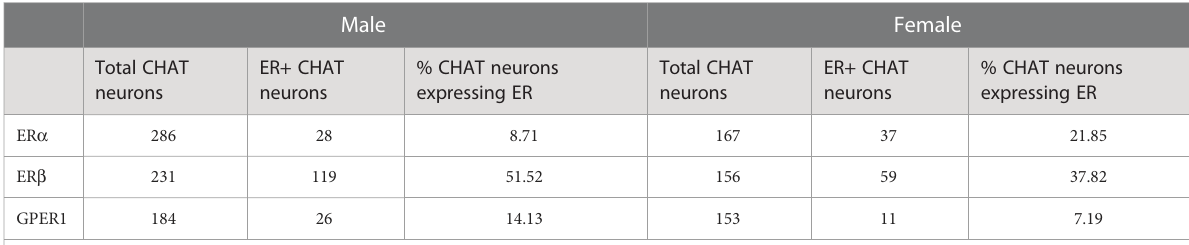
TABLE 1 Expression of estrogen receptor mRNAs in striatal cholinergic